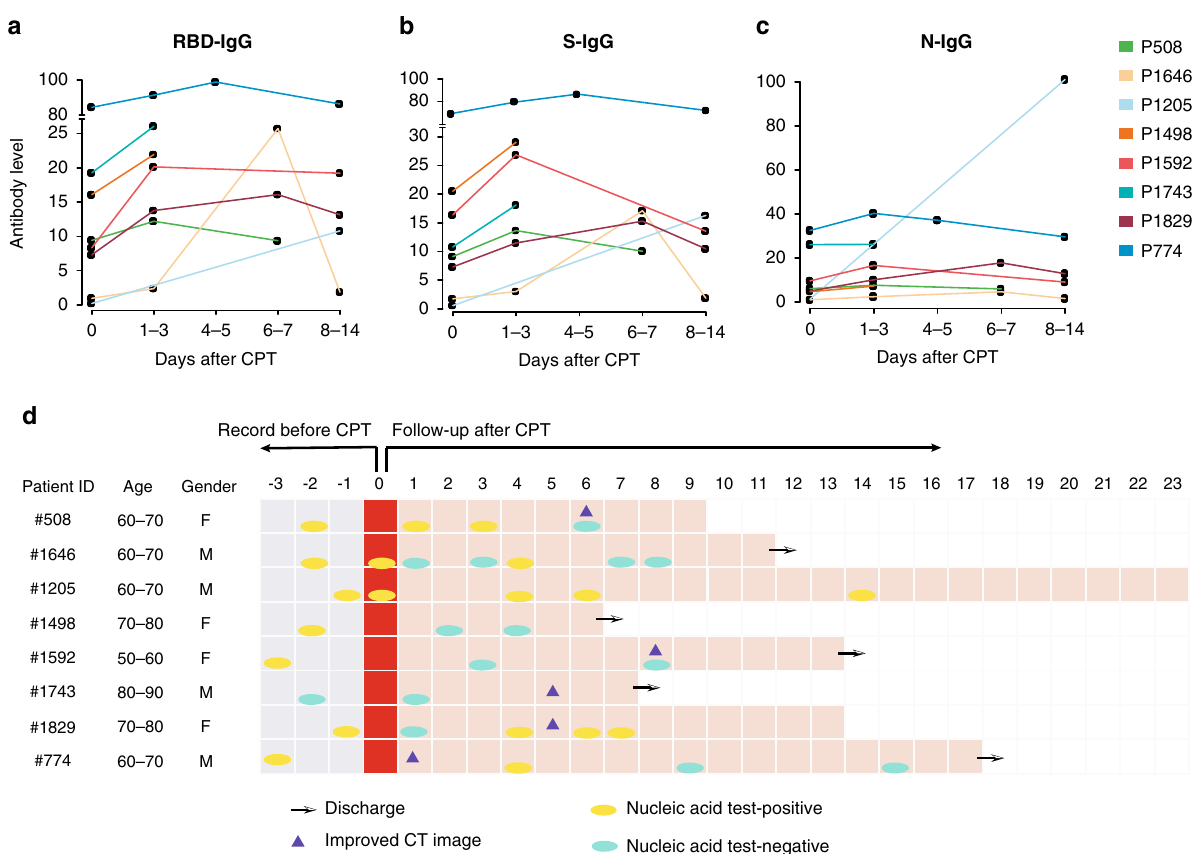
Fig. 4 Dynamic changes in the IgG levels after convalescent plasma transfusion. a – c The X axis represents the days since convalescent plasma transfusion therapy, and the Y axis represents the S-, RBD-, and N-speci fi c IgG levels. Different colored lines represent the dynamic changes in antibody levels in different patients. d The clinical assessment of patients after receiving COVID-19 convalescent plasma transfusion therapy. Arrows represent the patients ’ discharge date. Triangles represent radiological improvements. Yellow and green dots represent the date in which the RT-PCR tests for SARS- CoV-2 RNA were positive and negative,